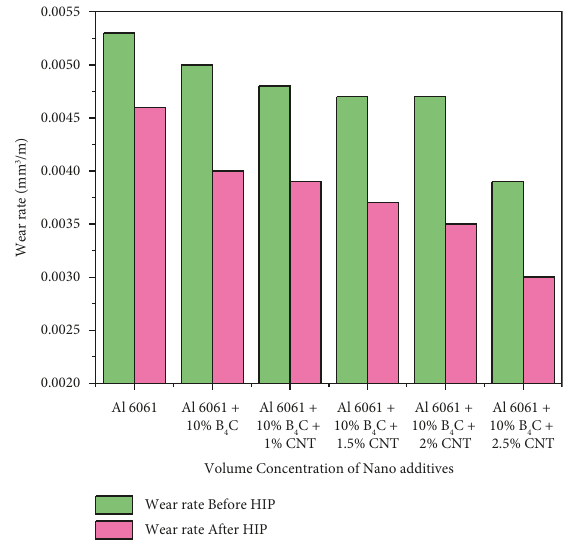
Figure 7: Before and after HIP wear